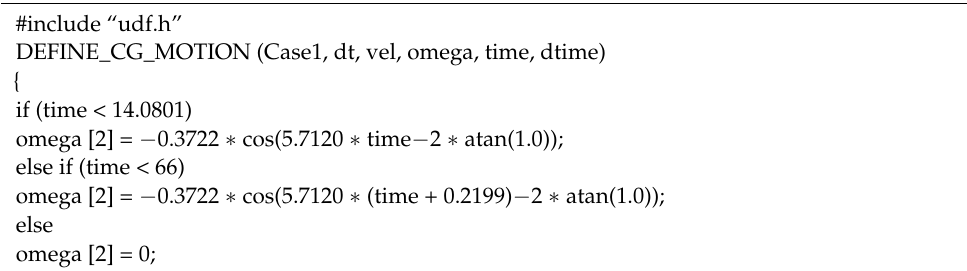
Algorithm 1 Computer programming codes provided for flap in Fluent software.